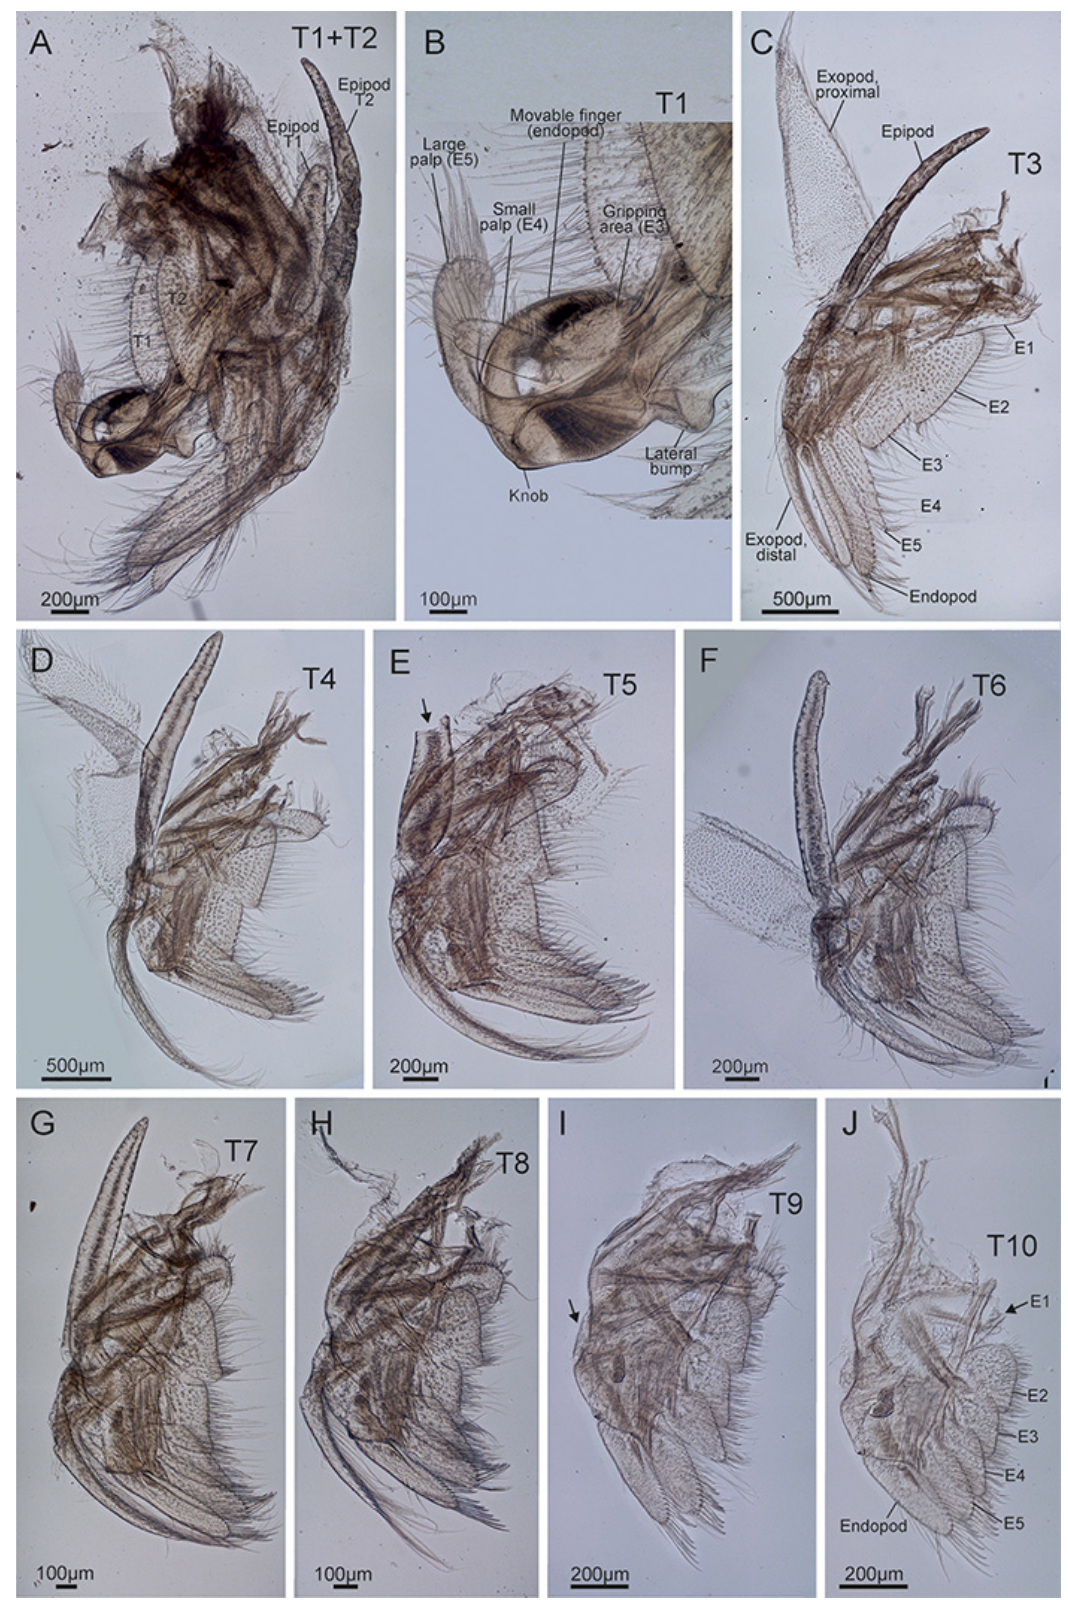
Figure 9. Lynceus grossipedia n. sp., male, light microscopy of right side thoracopods (unmodified) (paratype, NHMD-616086). A. Thoracopods I (male clasper) and II, seen from posterior. B. Higher magnification of clasper. C–K. Thoracopods III–X, seen from anterior; all of “regular” Lynceus type (= unmodified). Arrows indicate broken/hidden